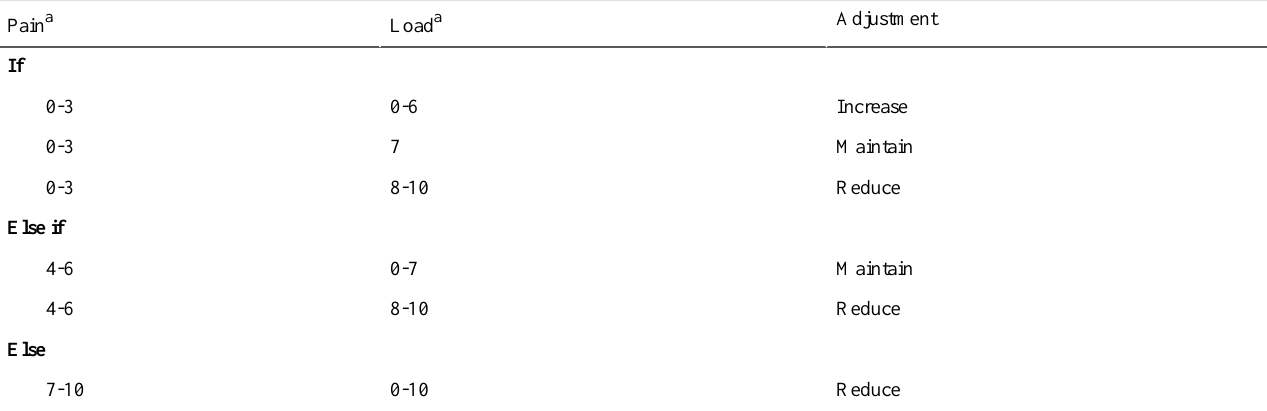
Table 3. Weekly individual training adjustment